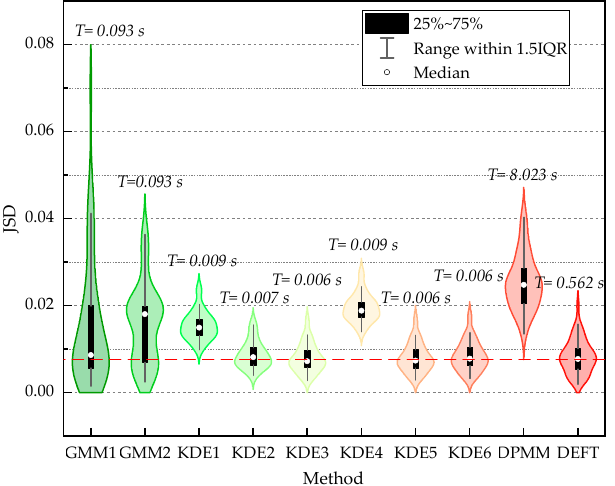
Figure 8. The JSD and average cost time results of fitting 50 random datasets of size 100 generated from f ( x 1 )